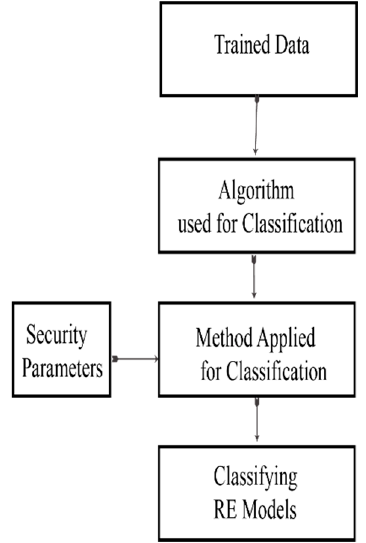
Figure 2. Flow Diagram for classification of RE model.